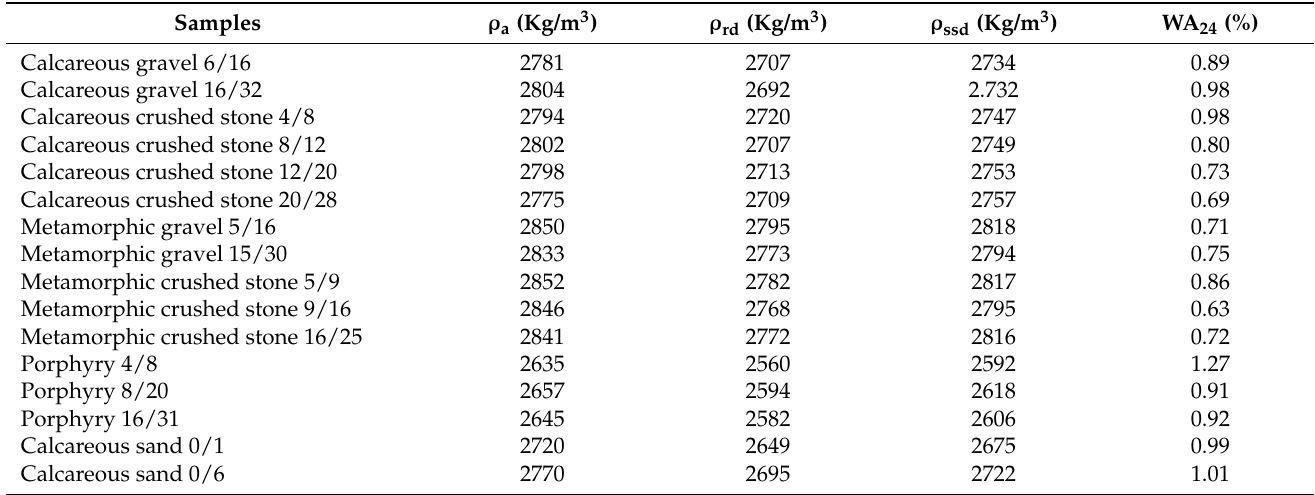
Table 10. Bulk density ( ρ a = apparent particle density; ρ rd = particle density on an oven-dried basis; ρ ssd = particle density on a saturated and surface-dried basis (expressed in Kg/m 3 )) and water absorption (WA, expressed in percentage) values determined in the analyzed samples [24].